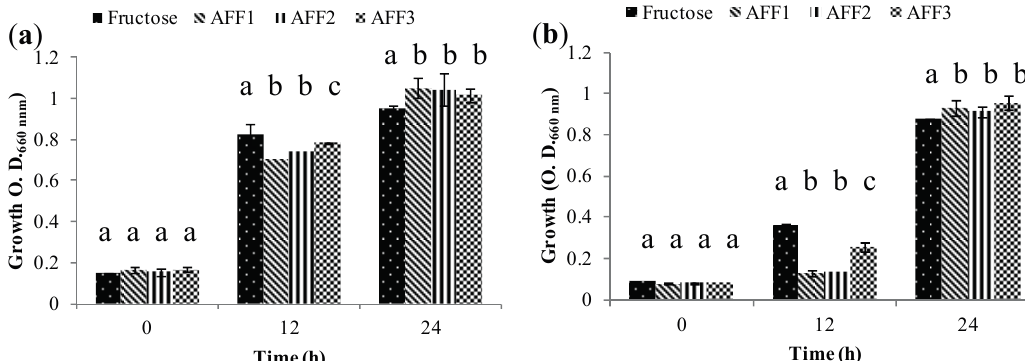
Figure 7. Growth (O.D.) of probiotic bacteria in the Group 4 (G4) at 0, 12 and 24 h in semi-synthetic medium using AFF1, AFF2, AFF3 as the sole carbon source and fructose as the fermentation control. ( a ) Lactobacillus paracasei subsp. paracasei. ( b ) Bifidobacterium bifidum ATCC